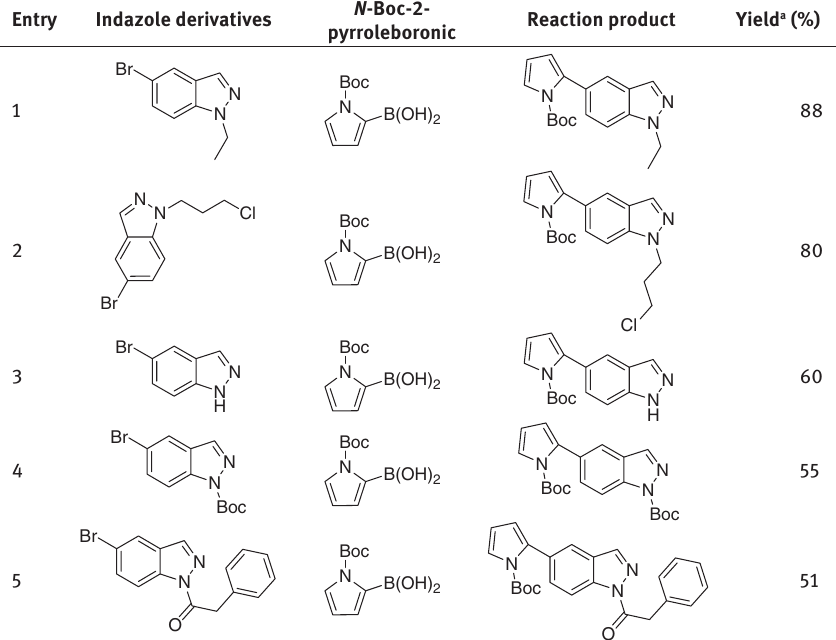
Table 3: Catalytic application of Pd/reduced graphene oxide (rGO) for novel synthesis.